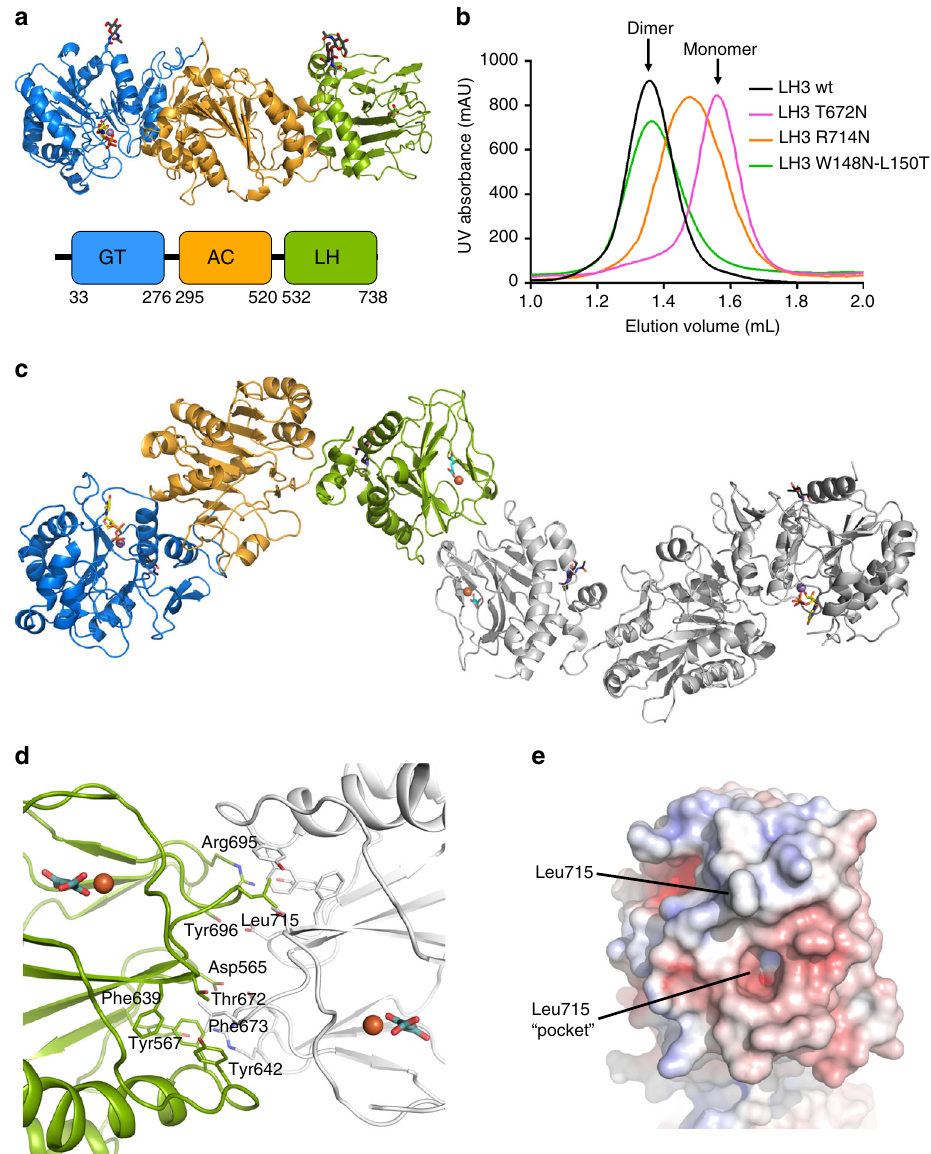
Fig. 1 Molecular architecture of human LH3. a Cartoon representation of the LH3 enzyme, showing its organization with three domains aligned from the N- to the C- terminus. Based on results of functional assays, the fi rst two glycosyltransferase domains have been named GT (catalytic glycosyltransferase, blue) and AC (accessory, orange), respectively. The C-terminal domain hosts the Fe 2 + and 2-OG cofactors necessary for lysyl hydroxylase activity, and therefore has been named LH (green). Metal ions are shown as spheres, cofactors and glycans as sticks. b Introduction of additional glycosylation sites identi fi es the LH3 dimer interface in solution. Glycosylated mutants R714N and T672N induce disruption of the dimeric assembly, as observed in analytical size exclusion chromatography experiments. Control glycosylated mutant W148N-L150T, located at a crystal contact interface, is a dimer as wild-type LH3. c Overview of the LH3 dimer as observed in the crystal structures. The quaternary arrangement highlights an elongated tail-to-tail dimer extending for over 20 nm in one direction, connected through strong electrostatic and hydrophobic interactions near the LH catalytic site. Fe 2 + and 2-OG in the neighboring catalytic site are shown with spheres and sticks, respectively. For clarity, one LH3 monomer is colored as in a , whereas the other is shown in white. d The molecular interface connecting two C-terminal LH domains in the LH3 crystal structure is characterized by strong hydrophobic interactions involving Leu715 of one monomer (green) and various aromatic residues shaping a cavity on the opposite monomer (white). This hydrophobic contact is surrounded by electrostatic interactions. For clarity, only the amino acids of one monomer are labeled. e Details of the LH3 dimer interface. Shown is the electrostatic potential computed using APBS 70 colored from − 10 k b Te c − 1 (red) to + 10 k b Te c − 1